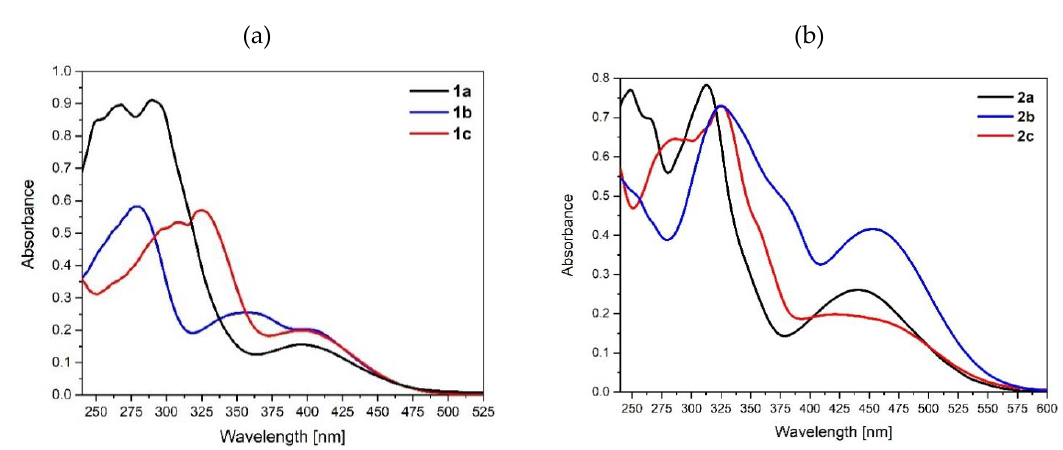
Figure 4. ( a ) Absorption spectra of 1a–1c and ( b ) 2a–2c in a chloroform solution (c = 10 −5 mol L −1 ). Table 4. Photophysical data for 2a–2c and precursors 1a–1c recorded in a chloroform solution. Code